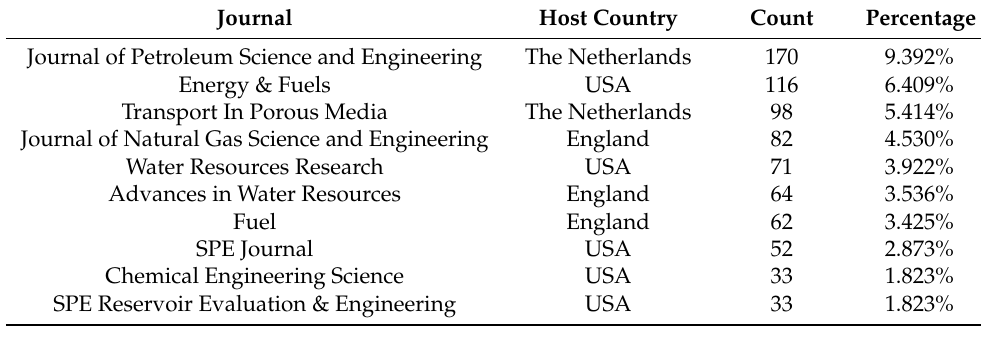
Table 3. Top 10 journals by the number of publications.